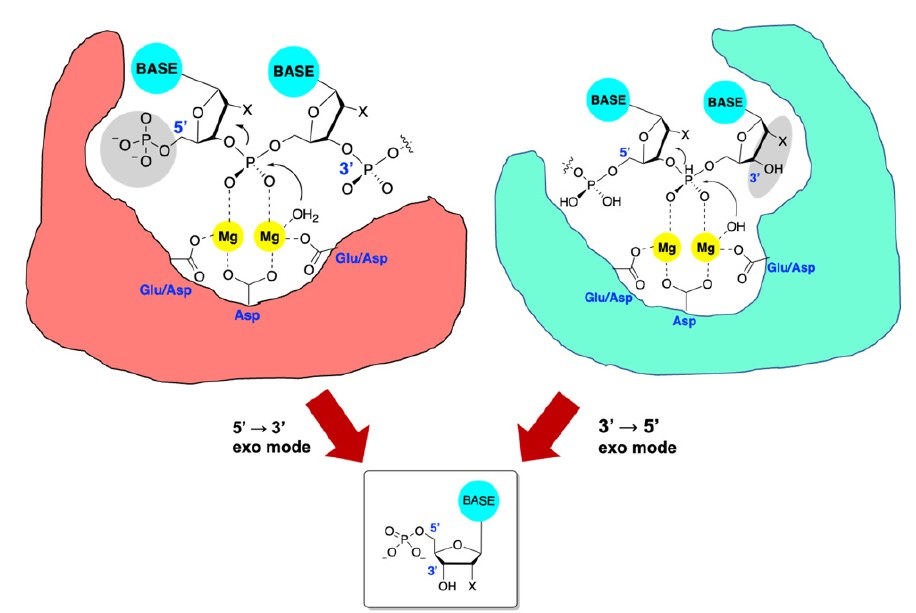
Figure 1. Exonuclease active sites have evolved to bind free 5 ′ or 3 ′ ends on DNA or RNA (but in a sequence-independent manner). The scissile phosphodiester is bound to the two divalent magnesium ions anchored by the DDE-type motifs, and an activated water molecule attacks the phosphorous atom in an S N2 displacement. Regardless of the manner of cleavage, a single ribo- or deoxyribonucleotide monophosphate is produced, generating a new 3 ′ or 5 ′ terminus for further cleavage. Important recognition domains are gray. Key recognition elements in grey, BASE=A, T, G, C or U, Mg=divalent magnesium, Glu=glutamic acid, Asp=aspartic acid, X=H or OH.